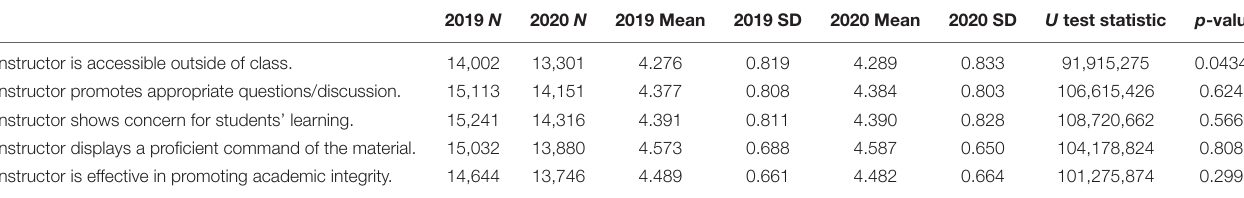
TABLE 3 | Student responses on CAPE evaluation statements relating to instructor efficacy and